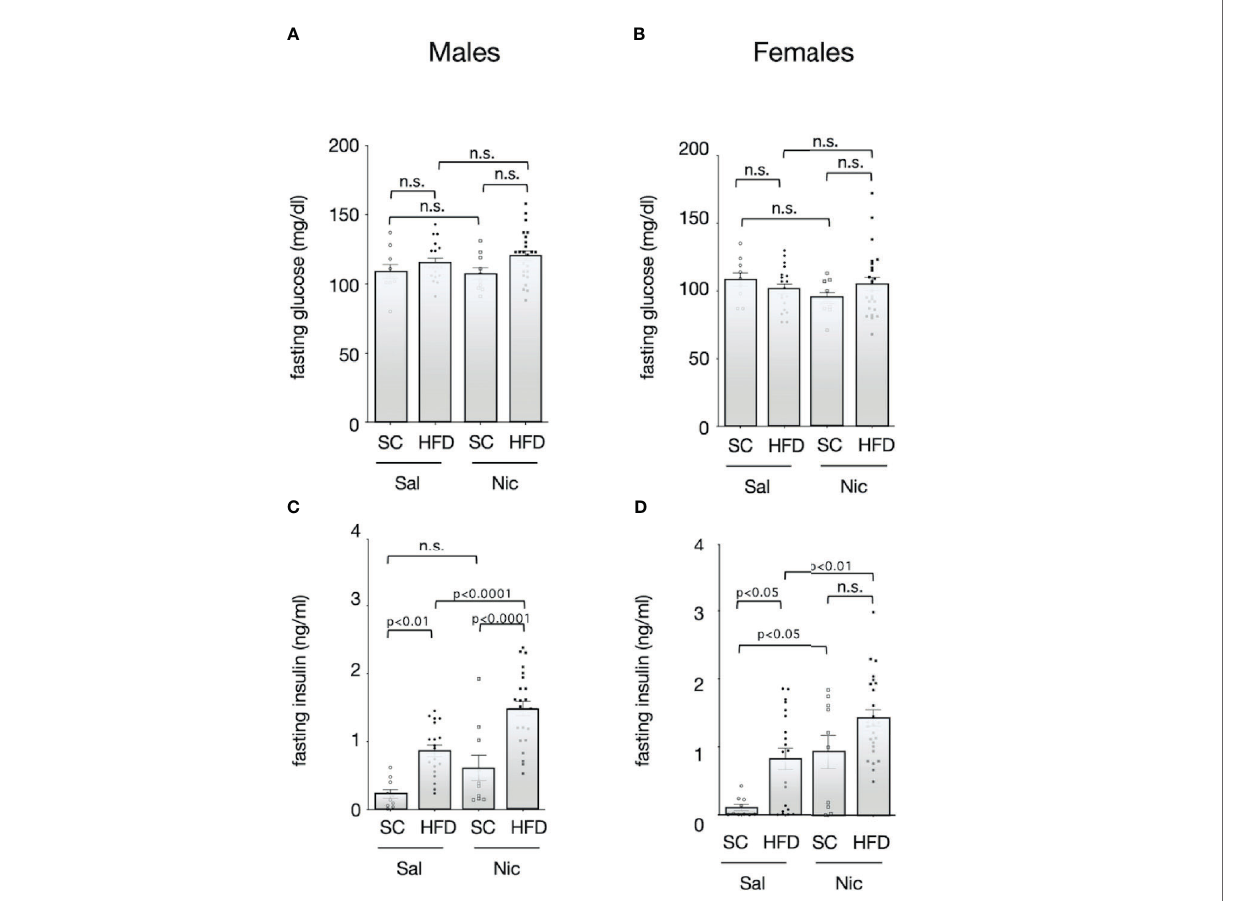
FIGURE 3 | Fasting blood sugar and insulin levels. Plasma concentrations of glucose ( A for males and B for females) and insulin ( C for males and D for females) of standard chow-fed (SC) offspring or high fat diet (HFD)-exposed offspring from nicotine-administered dams (NIC) or saline-treated dams (Sal) were measured (13- week-old). Values are presented as means ± SEM. Statistical analysis was performed using one-way ANOVA followed by Tukey ’ s post hoc test for multiple comparisons. n.s., not signi fi cant (p ≥